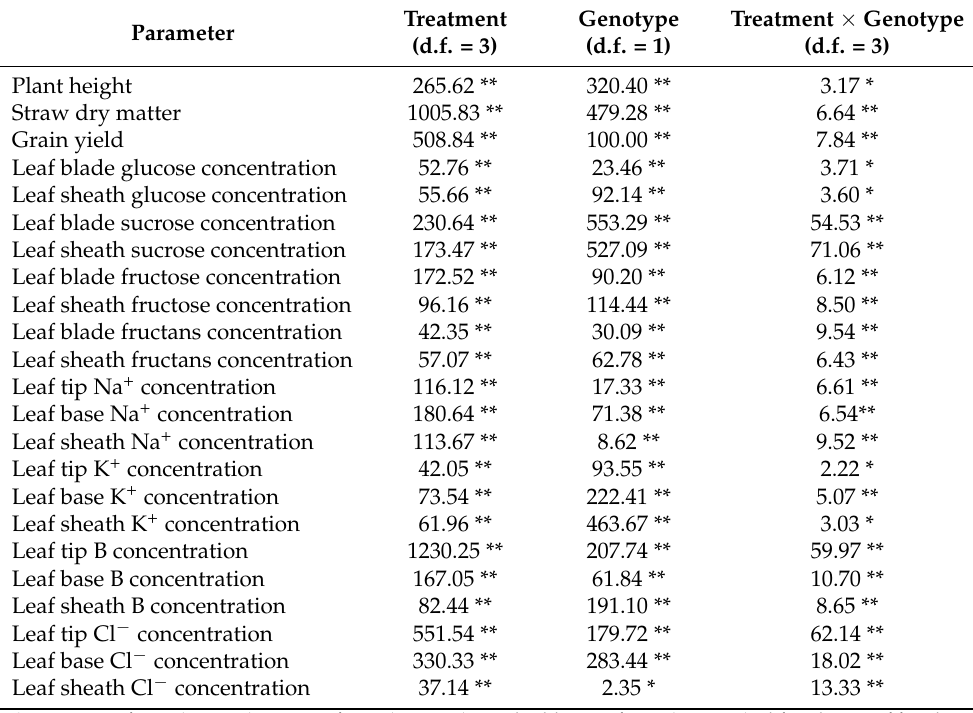
Table 2. F-values of two-way ANOVA for the effect of soil salinity and high boron on the carbohydrate partitioning, growth, and ionic compartmentalisation of wheat